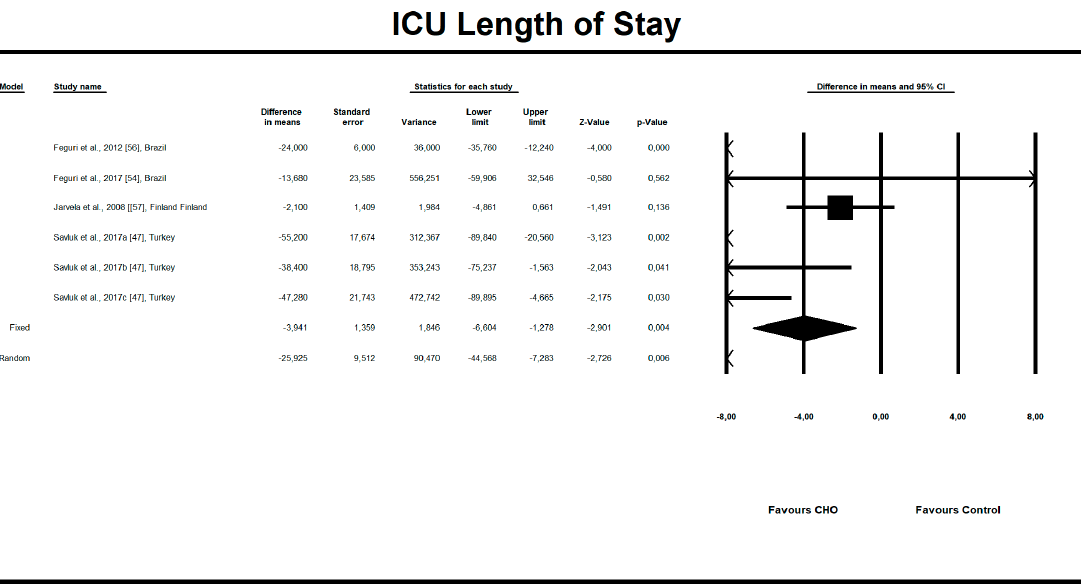
Figure 5. An e ff ect size, di ff erence in means, for intensive care unit (ICU) stay (hours) in patients taking Figure 5. An effect size, difference in means, for intensive care unit (ICU) stay (hours) in patients oral carbohydrates (OCH) drinks vs. controls. 95%Cl—95% confidence taking oral carbohydrates (OCH) drinks vs. controls. 95%Cl – 95% confidence interval.